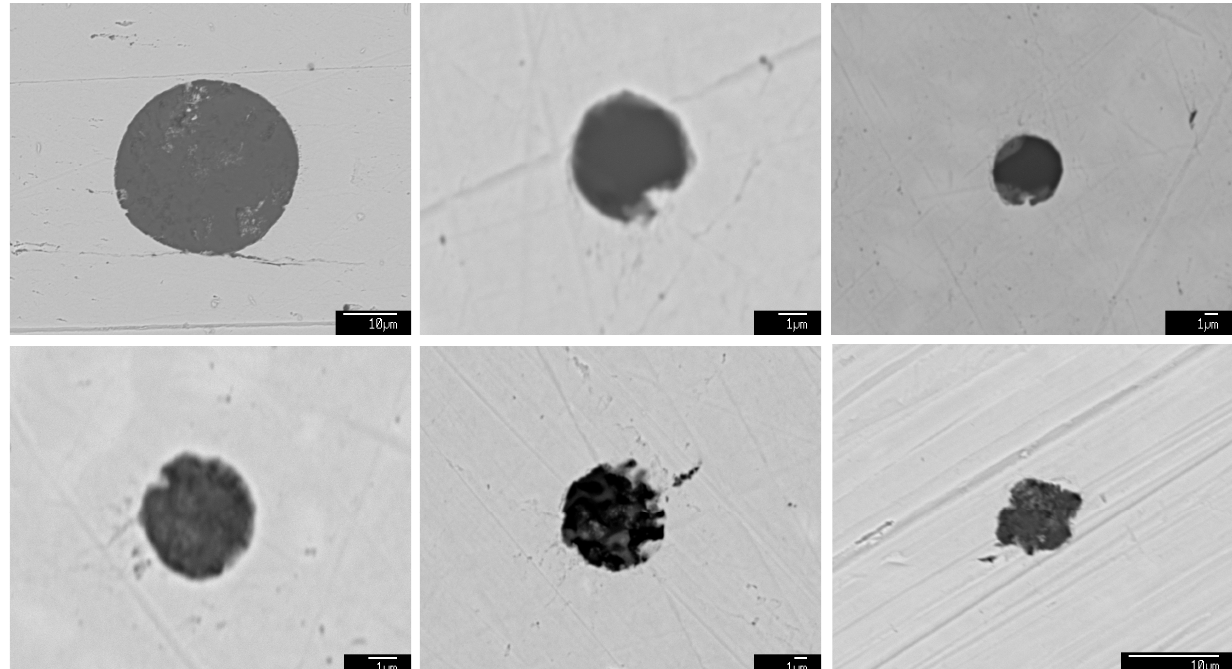
Figure 11. The morphologies of CaO-Al 2 O 3 -SiO 2 inclusions at different stages.